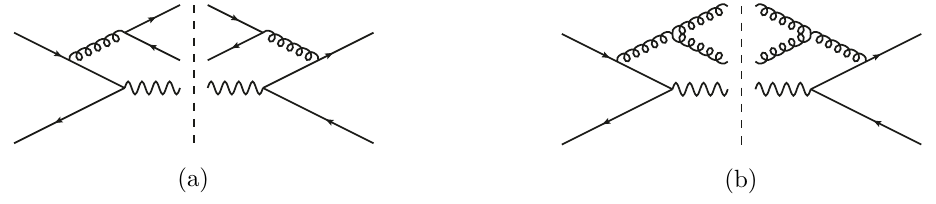
Figure 1. Contributions to the colour factors C F T R (left) and C A C F